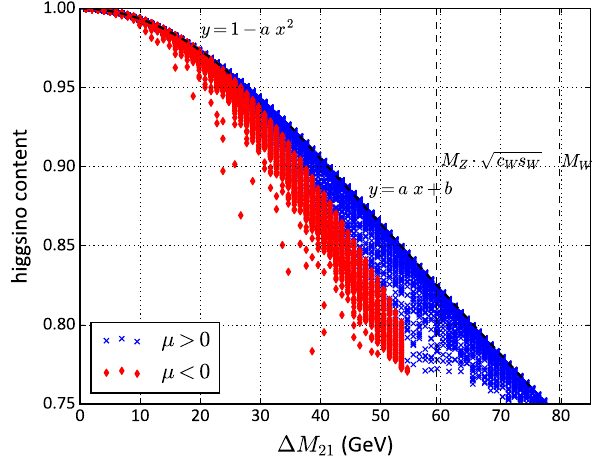
Fig. 4 Higgsino content as a function of Δ M 21 for our fit scenarios with μ > 0 (blue crosses) and μ < 0 (red diamonds). In both cases it falls quadratically for Δ M 21 < 25 GeV. For μ > 0, the fall-off is linear beyond this